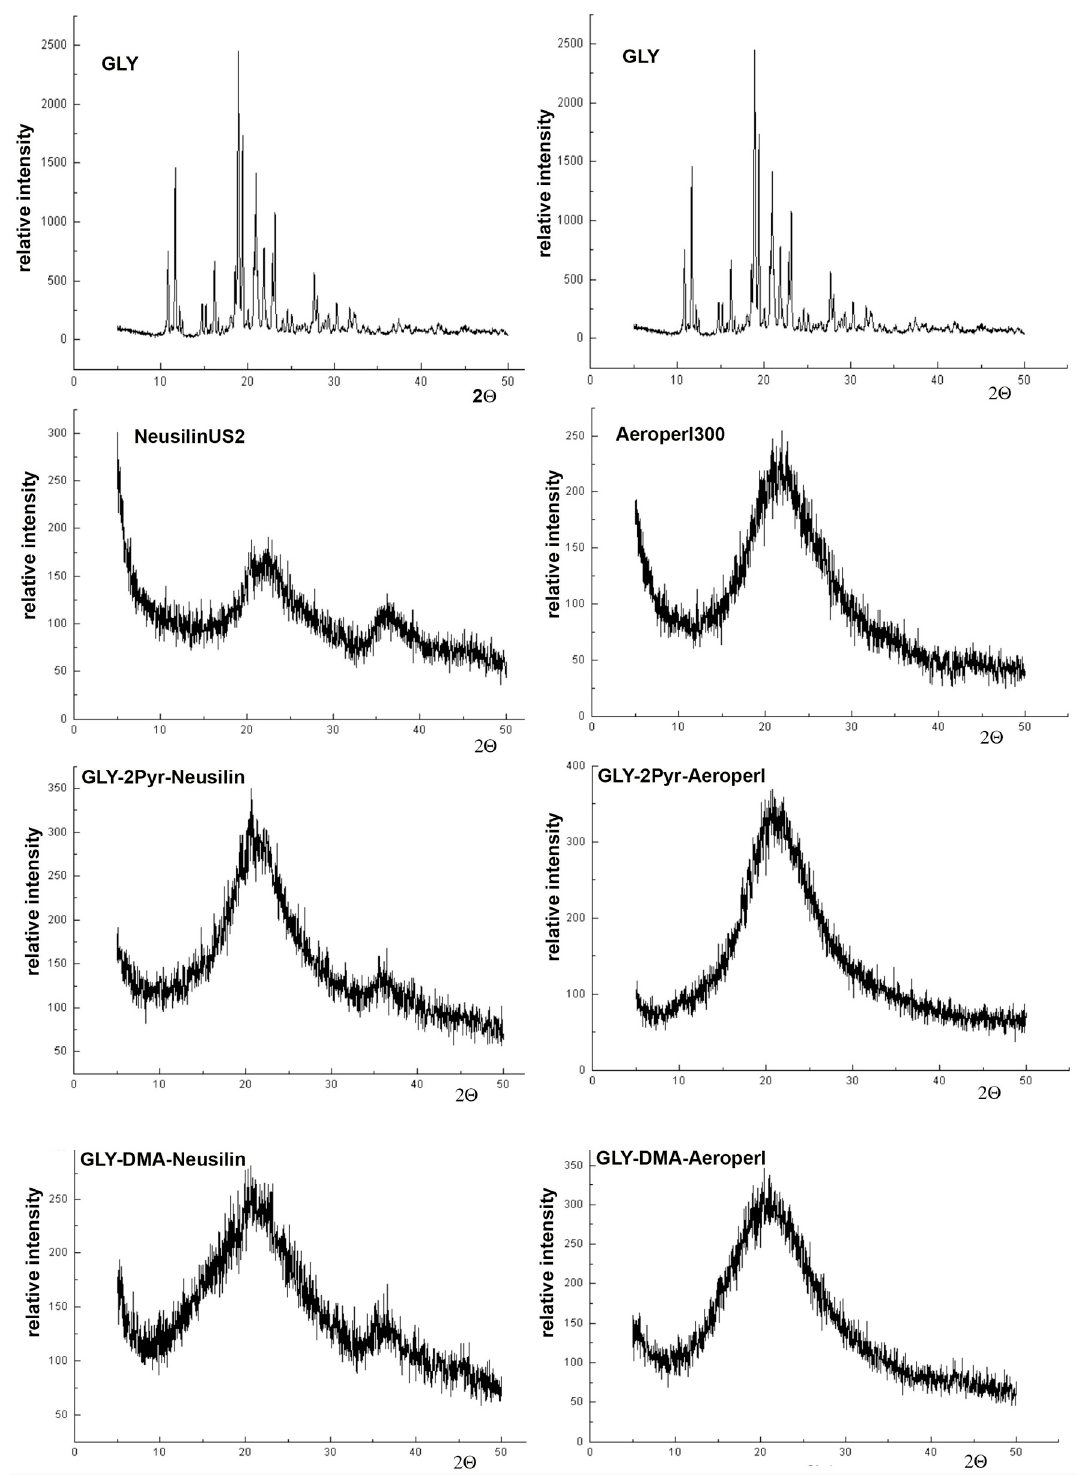
Figure 4. X-Ray powder diffraction patterns of pure glyburide (GLY), Neusilin ® US2 and and of the corresponding liquisolid systems with 2-pyrrolidone (2-PYR) or dimetylacetamide (DMA) Aeroperl ® 300 and of the corresponding liquisolid systems with 2-pyrrolidone (2-PYR) or as non-volatile water miscible dimetylacetamide (DMA) as non-volatile water miscible solvent.